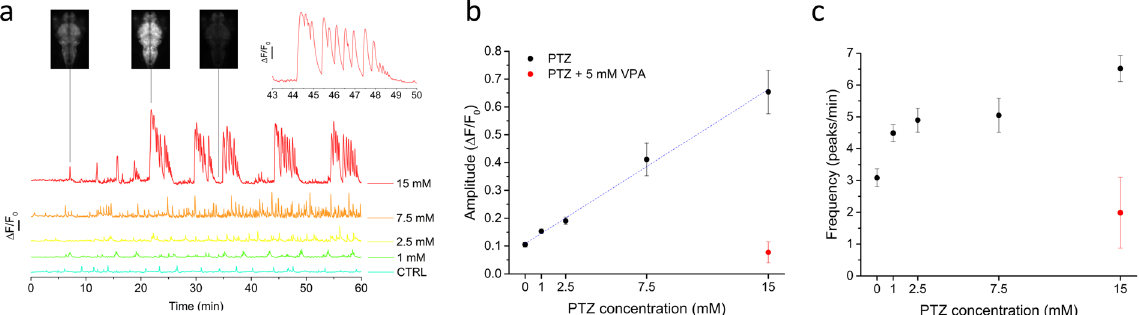
Figure 2. Comparison of the effects of different PTZ concentrations on brain activity. ( a ) Δ F/F 0 is plotted as a function of time for control conditions and increasing PTZ concentrations as indicated. Upper left panels show images acquired at the points indicated during the recording at 15 mM PTZ, demonstrating the large dynamic range of the signal and lack of saturation even at the highest recorded levels. The inset on the upper right shows a single cluster of closely spaced calcium spikes occurring at 15 mM PTZ and displayed on a magnified time scale. Δ F/F 0 calibaration bar: 100%. ( b ) Mean amplitude of peaks detected over one hour registration for each larva recorded (see Methods for details about automatic peak detection). The red symbol represents measurements performed on larvae treated with 15 mM PTZ after a pre-incubation of one hour in 5 mM Valproic acid (VPA). The linear regression through the PTZ-only measurements (dashed line) produces a slope of 0.037/mM, Pearsons’s r = 0.992. Number of larvae measured: 6 (0 mM), 7 (1 mM), 5 (2.5 mM), 6 (7.5 mM), 7 (15 mM), 3 (15 mM + VPA). Error bars are s.e.m. and where not visible are smaller than the symbol size. ( c ) Mean peak frequency as a function of PTZ concentration. The number of larvae is the same as in panel